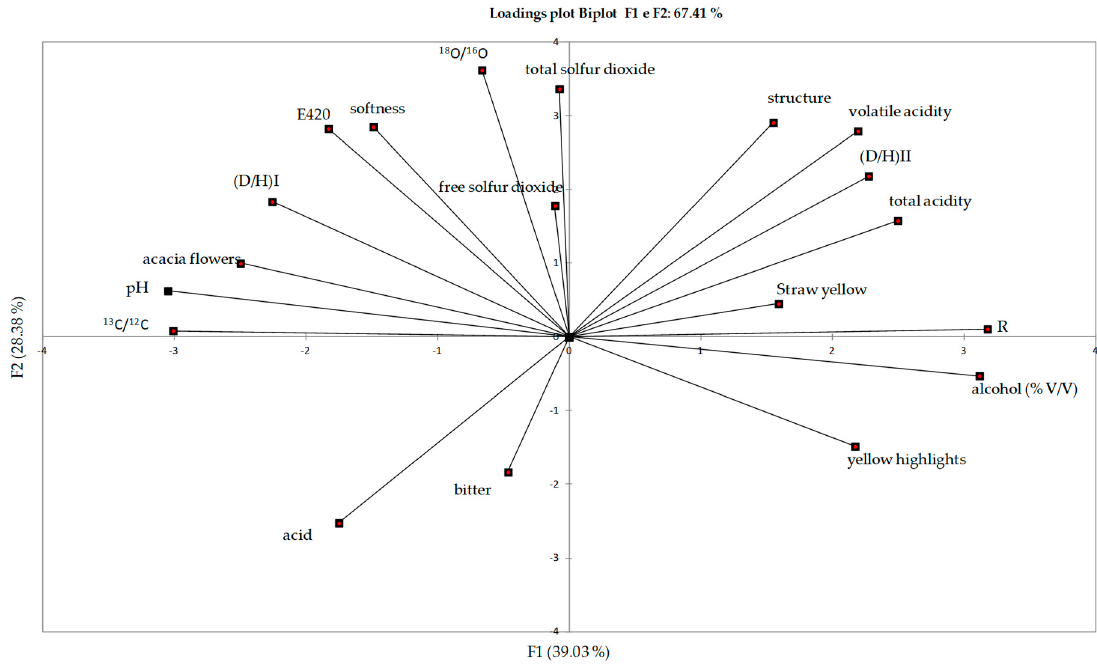
Figure 4. Loadings plot for white wines (Verdicchio and Fiano) in the two vintages (2009–2010).